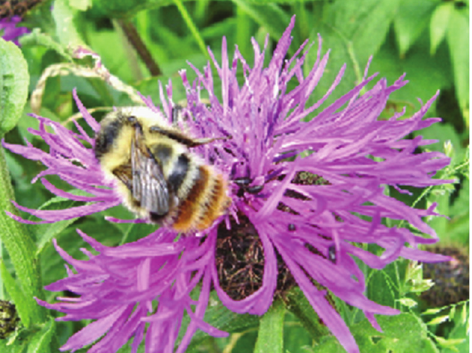
Figure 11: Young queen of B. sylvarum feeding on Centaurea